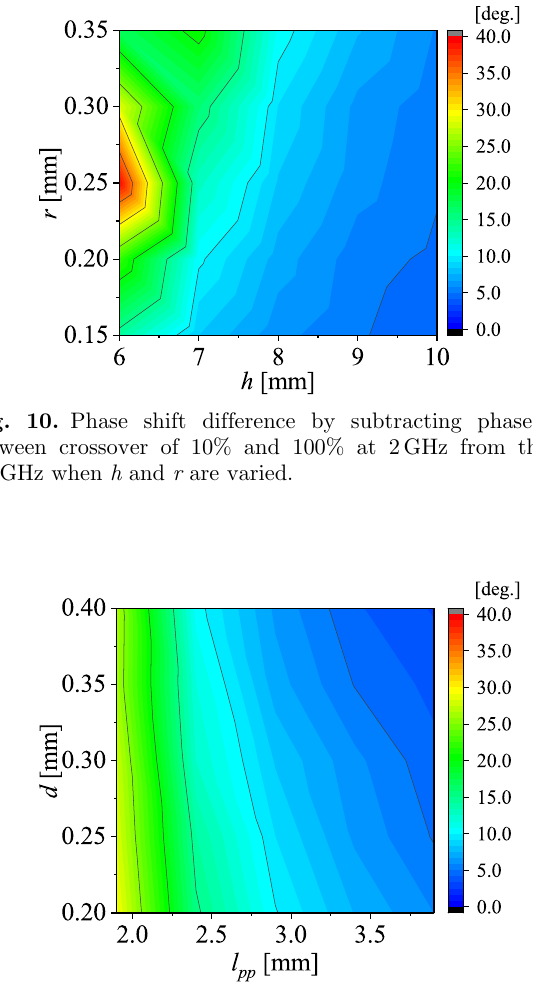
Fig. 11. Phase shift difference by subtracting phase shift between crossover of 10% and 100% at 2GHz from that at 1.5GHz when l pp and d are varied